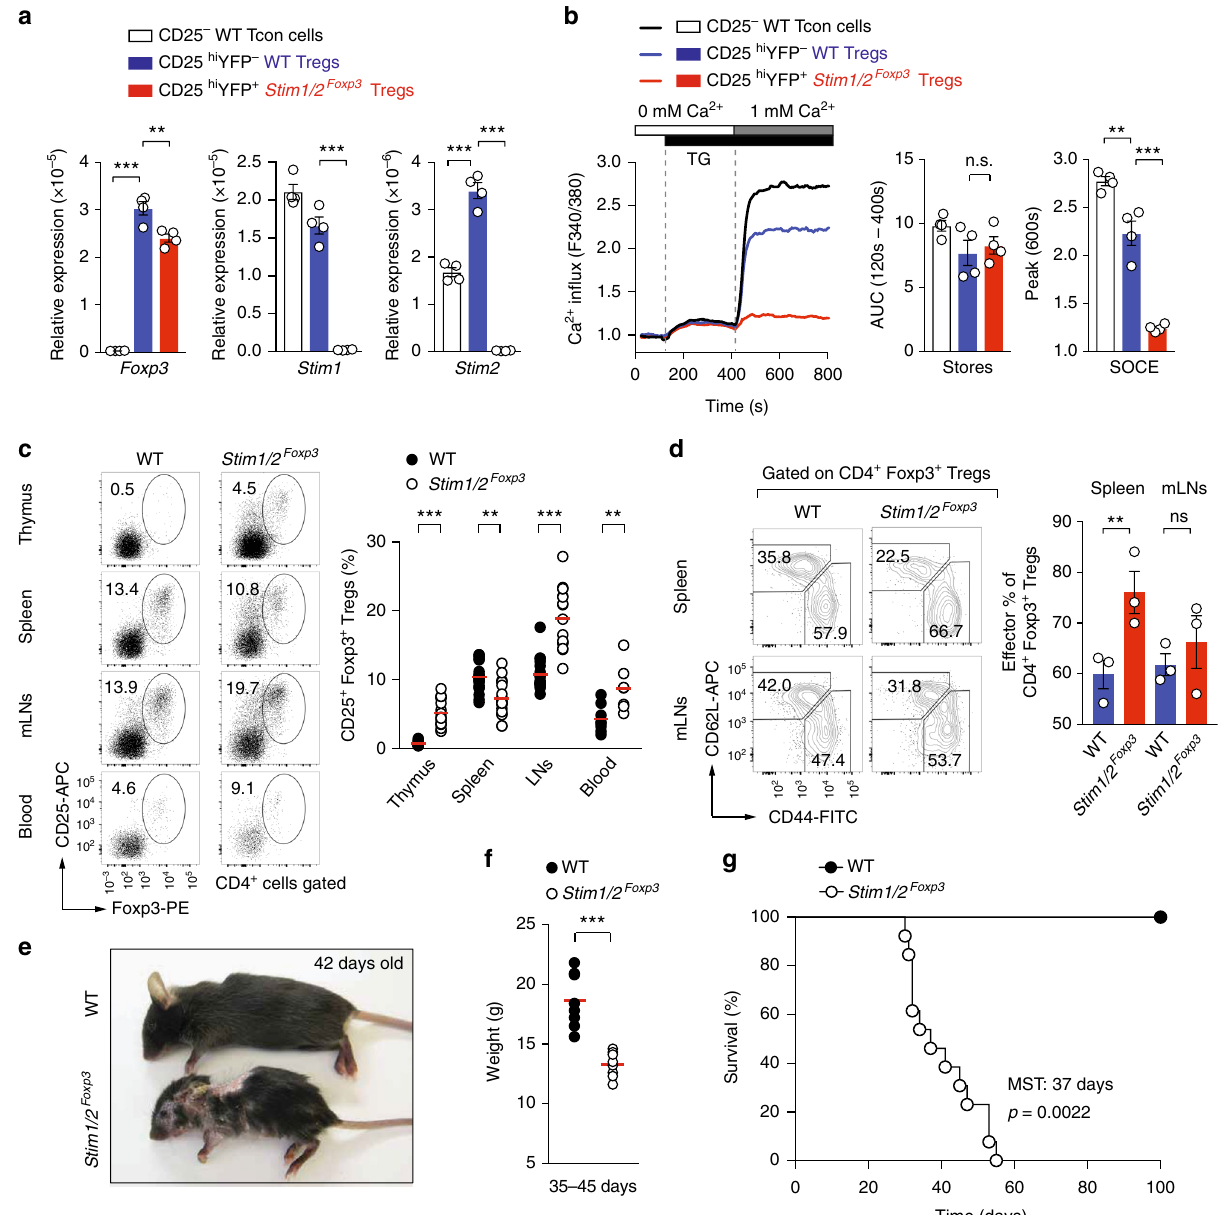
Fig. 1 Deletion of STIM1 and STIM2 in Treg cells is fatal despite normal Treg numbers in secondary lymphoid organs. a Analysis of Stim1 , Stim2 , and Foxp3 gene expression in conventional and Treg cells isolated from male WT and Stim1 fl / fl Stim2 fl / fl Foxp3cre ( Stim1/2 Foxp3 ) mice using qRT-PCR. Means ± SEM of four mice. b Analysis of Ca 2 + in fl ux in T conventional (Tcon) and Treg cells isolated from male WT and Stim1/2 Foxp3 mice loaded with Fura-2 and stimulated with thapsigargin (TG) in Ca 2 + free Ringer solution followed by addition of 1 mM Ca 2 + (left panel). Normalized store depletion (AUC 120s-400s ) and SOCE (peak 600s ) of T cells calculated as F340/380 emission ratios; means± SEM of four mice (right panels). c Analysis of Foxp3 + Treg cells in secondary lymphoid organs and blood of male WT and Stim1/2 Foxp3 mice using fl ow cytometry; means of 7 – 21 mice. d Analysis of naïve and effector Treg cells in spleen and mLNs of male WT and Stim1/2 Foxp3 mice using fl ow cytometry. Bar graphs represent the means ± SEM of three mice. e Representative pictures of 42 days old male WT and Stim1/2 Foxp3 mice. f Weight of 35 – 45 days old male WT and Stim1/2 Foxp3 mice; means of eight mice. g Cumulative survival of male WT and Stim1/2 Foxp3 mice; 9 – 13 mice per cohort. Mean survival time (MST) of Stim1/2 Foxp3 mice 37 days and of WT mice > 100 days. Each dot in c and f represents one mouse. Statistical analysis in a – d , f by unpaired Student ’ s t -test; in g using the Mantel – Cox test. * p < 0.05; ** p < 0.01; *** p < 0.001. AUC, area under the (Fig. 3a, Supplementary Figure 3b, c). Similarly, in activated by RNA-sequencing (Fig. 3a). The gene expression pro fi les of Treg cells more DEG were downregulated than upregulated unstimulated and anti-CD3/CD28-stimulated WT and Stim1/2 - (439 vs. 218) (Fig. 3a, Supplementary Figure 3b, c). We per- de fi cient Treg cells were clearly distinct (Supplementary Fig- formed unbiased pathway enrichment and network analyses of ure 3a). Of 1238 differentially expressed genes (DEG) in non- DEG in unstimulated Treg cells to determine biological pro- stimulated WT and Stim1/2 -de fi cient Treg cells, more genes cesses that are regulated by SOCE in Treg cells (Fig. 3b). were downregulated than upregulated (771 vs. 467) >two-fold